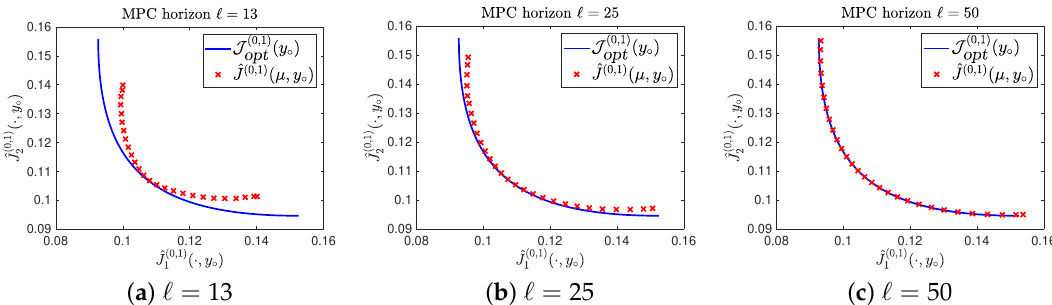
Figure 7. Comparison the results from Algorithm 3 and the Pareto